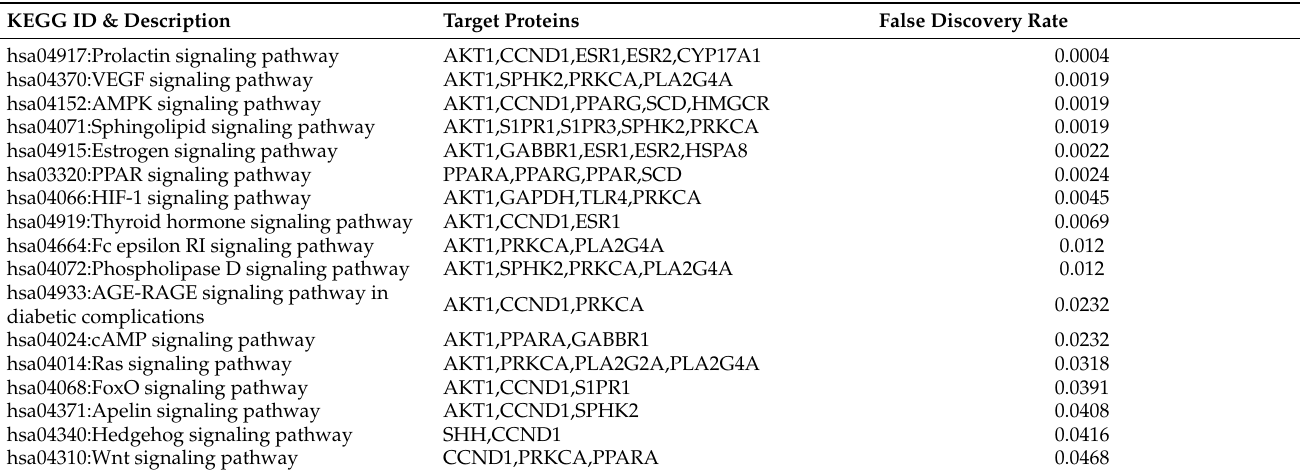
Table 4. Target proteins in 17 signaling pathways enrichment related to